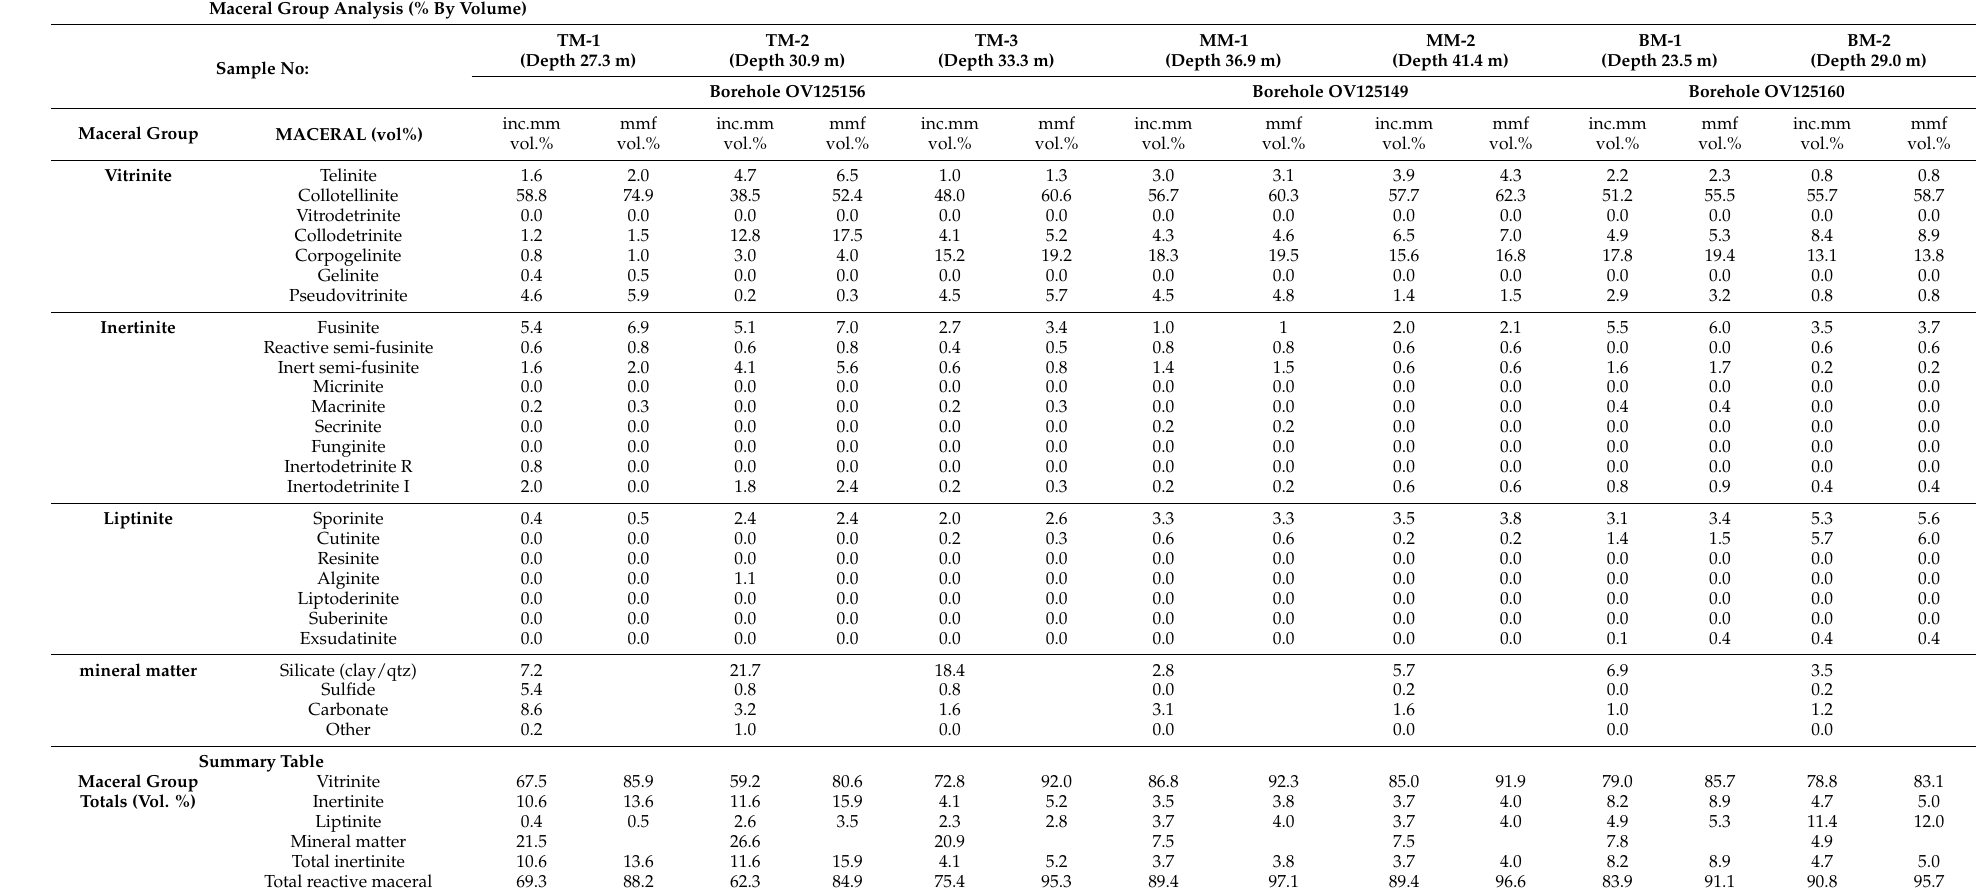
Table 2. Result of the maceral group